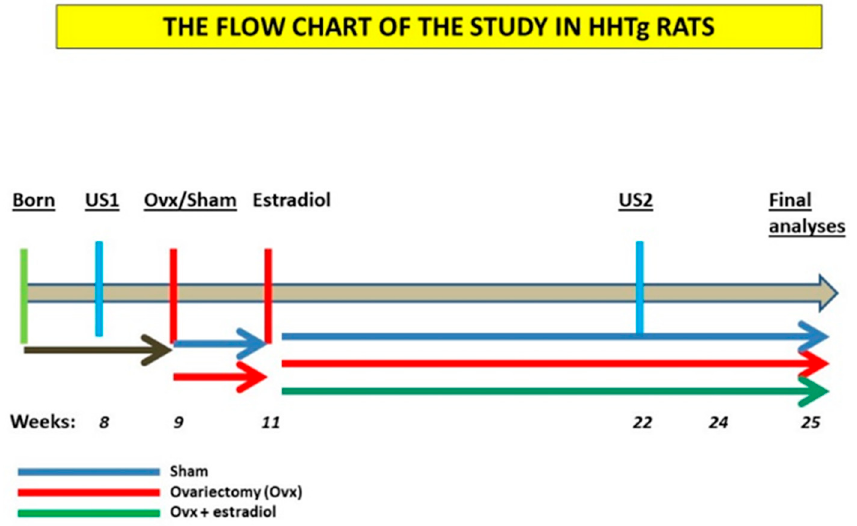
Figure 4. Flow chart of the experiment . HHTg: hereditary hypetriglycerdiemic, US1—first ultra- sound examination of abdominal aorta, US2—second ultrasound examination of abdominal aorta, Ovx: ovariectomy.